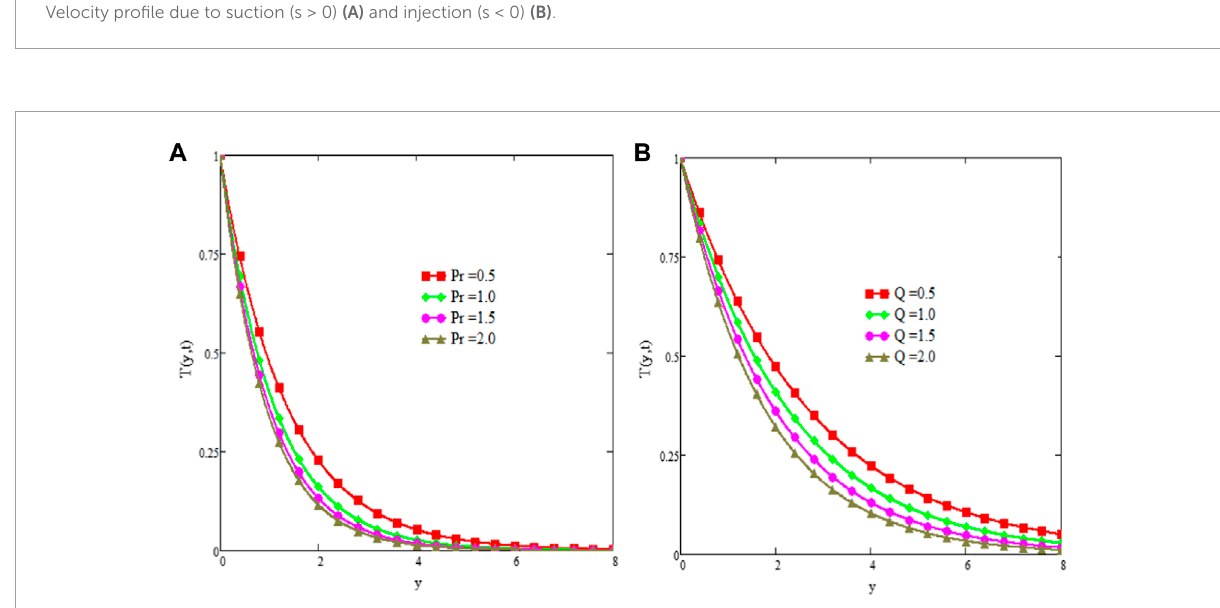
FIGURE 11 Temperature profiles for Pr (A) and Q (B)